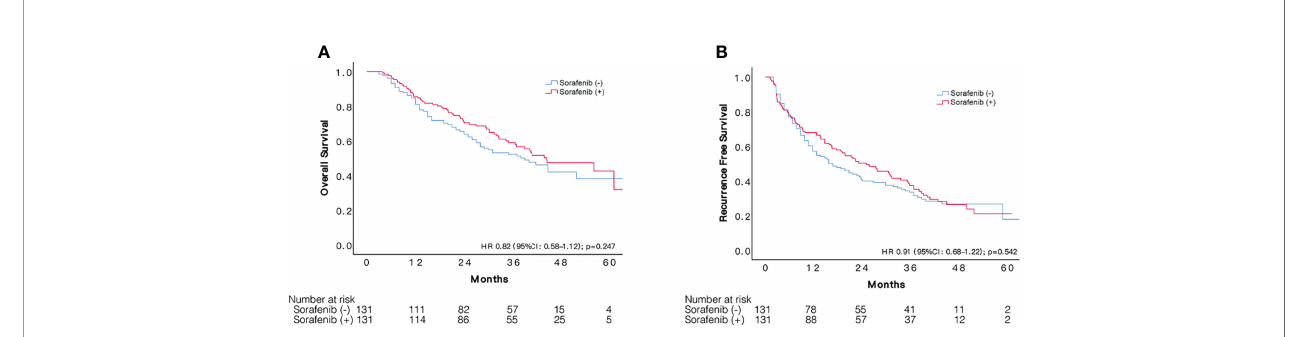
FIGURE 1 | Comparison of survival between patients with sorafenib treatment after resection and those had resection alone. Kaplan – Meier curves of OS (A) and RFS (B) of patients with and without adjuvant sorafenib treatment after liver resection.